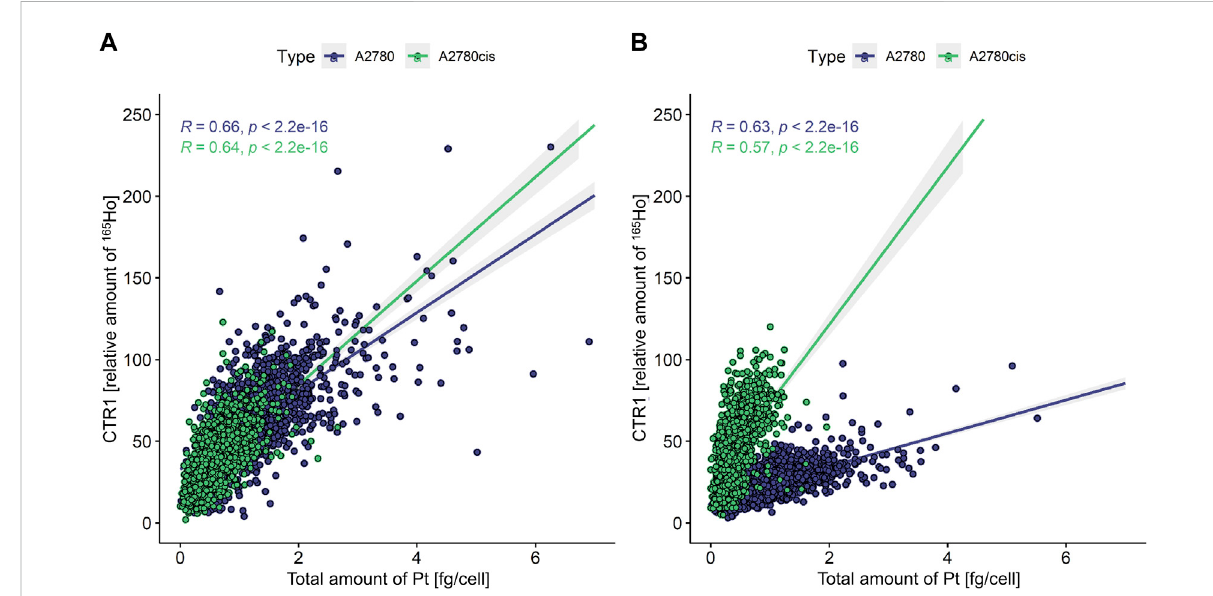
FIGURE 6 Scatterplot showing the total amount of Pt [fg cell − 1 ]versusthe relativeamount of 165 Ho [counts cell − 1 ]representing the amount of (A) total and (B) plasma membrane-associated CTR1. A Pearson correlation was calculated between those two variables for both A2780 and A2780cis cells. A value of 0.00 – 0.10 indicates a negligible correlation, 0.10 – 0.39 a weak correlation, 0.40 – 0.69 a moderate correlation, 0.70 – 0.89 a strong correlation, and a value of 0.90 – 1.00 a very strong correlation (Schober et al., 2018).